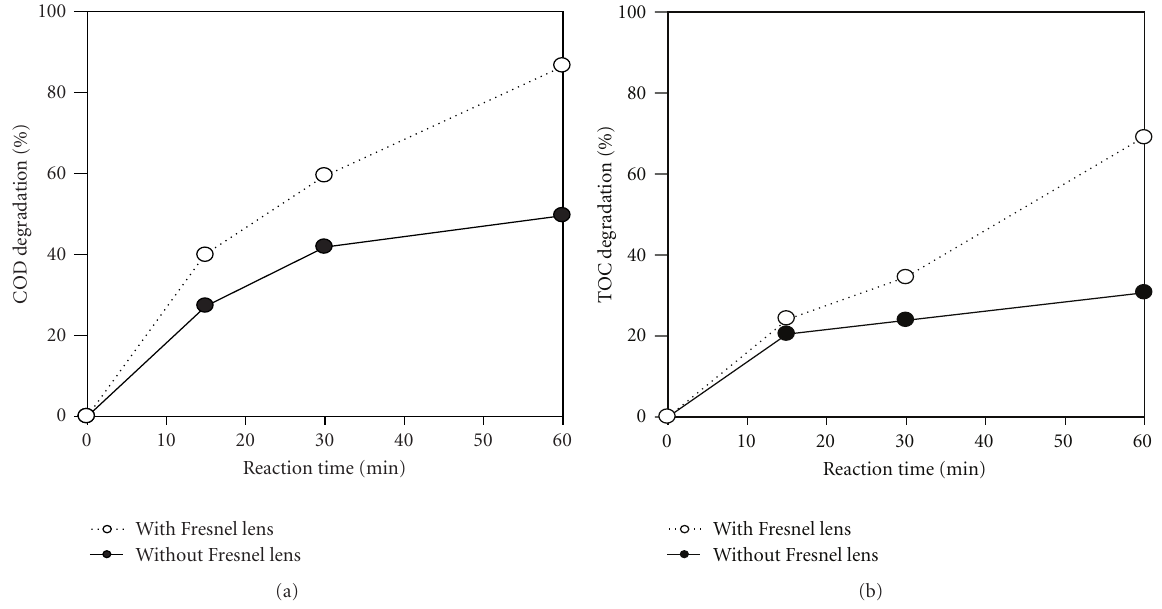
Figure 2: E ff ect of Fresnel lens on the degradation e ffi ciency of (a) COD and (b) TOC of color filter wastewater in solar photo-Fenton process (initial pH: 5.0; H 2 O 2 /COD = 1.25 g/g; [H 2 O 2 ] 0 /[Fe 2+ ] 0 = 15). Table 3: E ff ect of Fresnel lens on the degradation rate constant of color filter wastewater. Solar Photo-Fenton Process 138.09 ∗ Operation condition: pH = 15. 0: 5.0, 1.25g H 2 O 2 /g COD, [H 2 O 2 ] 0 /[Fe 2+ ] 0 ffi cient. a k COD : pseudo-first-order rate constant based on the degradation of COD in solution for 95% confidence coe ffi cient. b k TOC : pseudo-first-order rate constant based on the degradation of TOC in solution for 95% confidence coe c UV a+b : UV light (280–400nm) intensity.